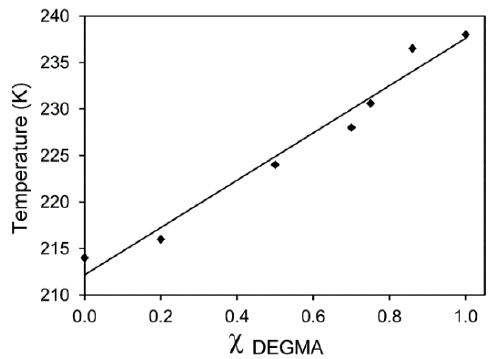
Figure 8. Thermograms obtained by modulated DSC of ( a ) POEGMA; ( b – f ) P(OEGMA- co -DEGMA):